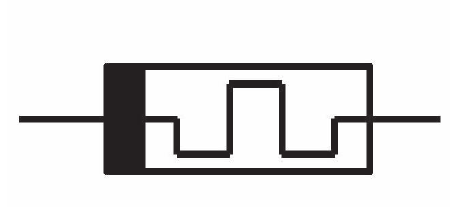
Fig. 3: Symbol representing a memristor in an electric